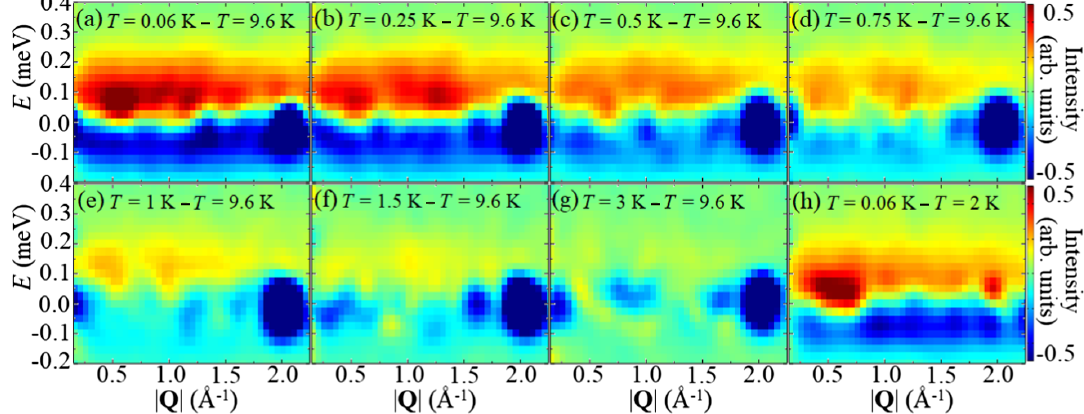
FIG. 15. The temperature evolution of the low energy inelastic neutron scattering from a powder sample of Ce 2 Zr 2 O 7 . A dataset measured at 9.6 K has been subtracted from a dataset measured at T ¼ 0 . 06 K (a), 0.25 K (b), 0.5 K (c), 0.75 K (d), 1 K (e), 1.5 K (f), and 3 K (g). (h) The powder-averaged neutron scattering signal measured at T ¼ 0 . 06 K from a single-crystal sample of Ce 2 Zr 2 O 7 , with a T ¼ 2 K dataset subtracted, is shown for comparison.